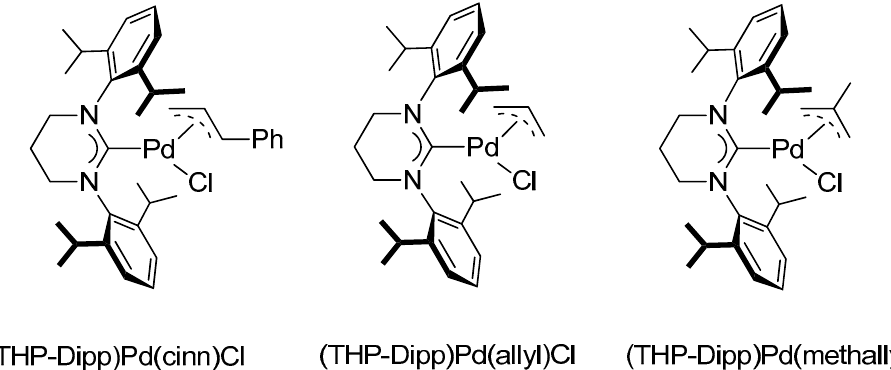
Figure 3. Structures of (THP-Dipp) Pd complexes.